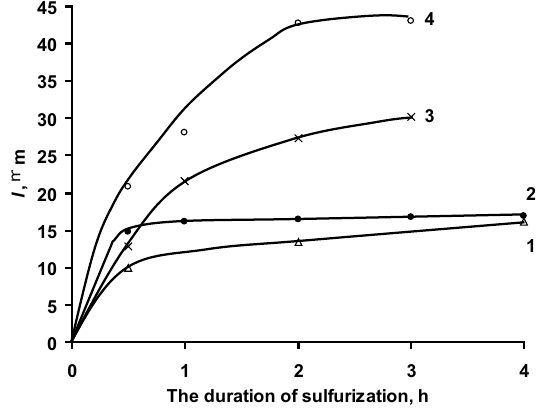
Figure 3. Dependence of the thickness of Cu